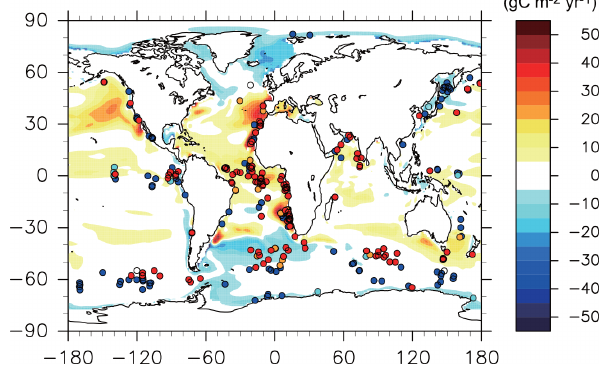
Figure 9. Primary production anomaly of the oceanic ecosystem (unit: gCm − 2 yr − 1 ). Anomalies are calculated as LGM relative to PI values. Circles denote qualitative changes in primary production derived from proxy data (Kohfeld et al.,